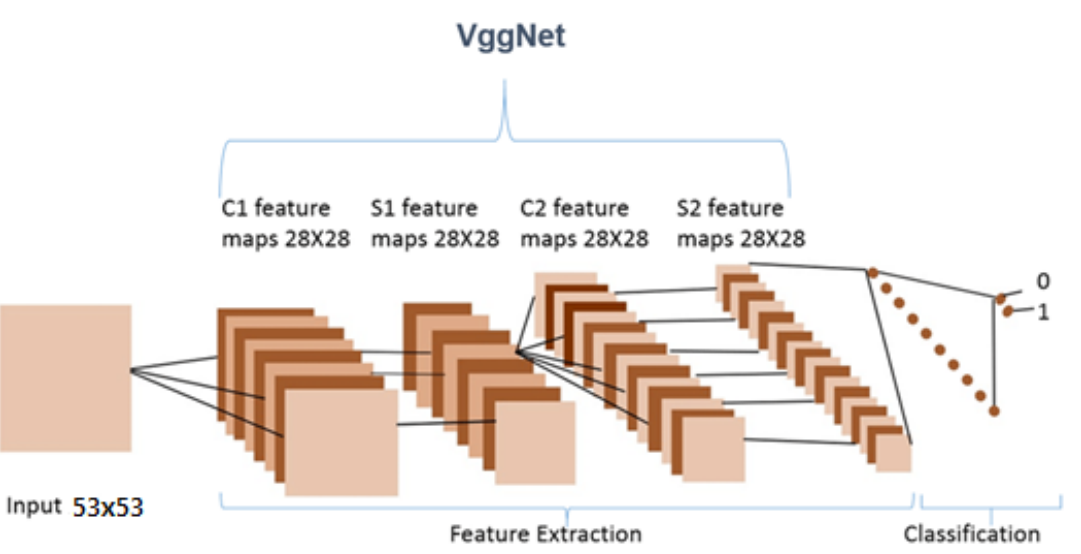
Figure 9. The architecture of CNN layers for feature extraction and classification [35]. The classifier is typically made up of fully connected layers.